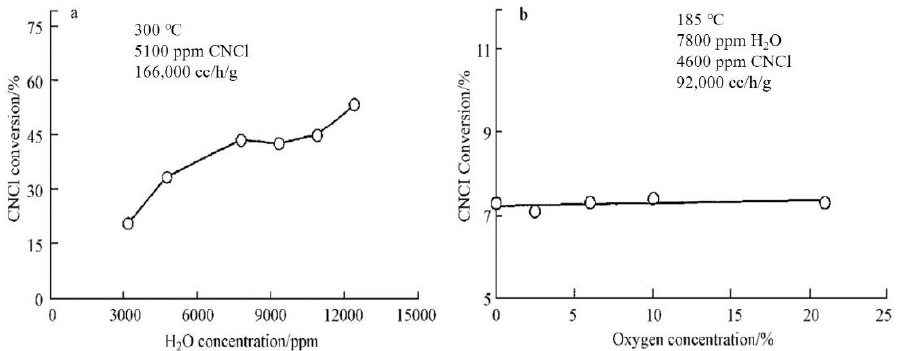
Figure 3. Effects of water ( a ) and oxygen ( b ) concentrations on the Pt/Al 2 O 3 -catalyzed thermal decomposition of CNCl [49].